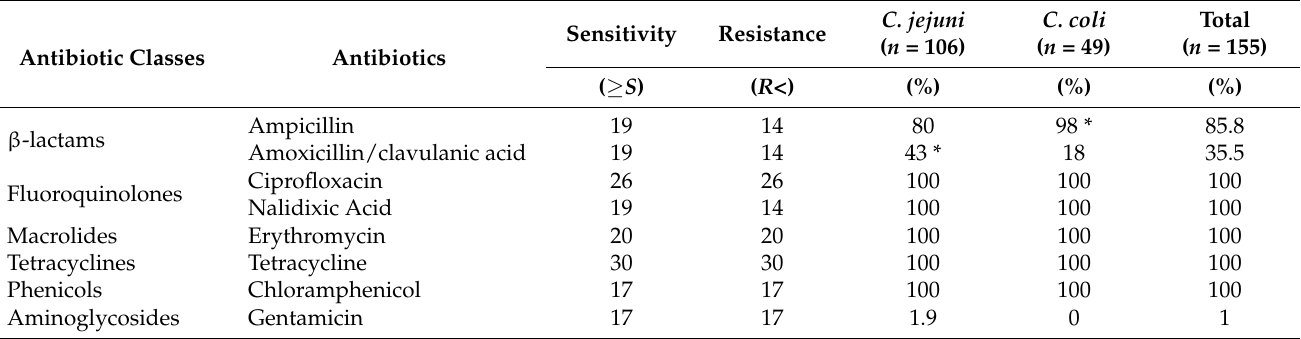
Table 2. Antimicrobial resistance rates in Campylobacter